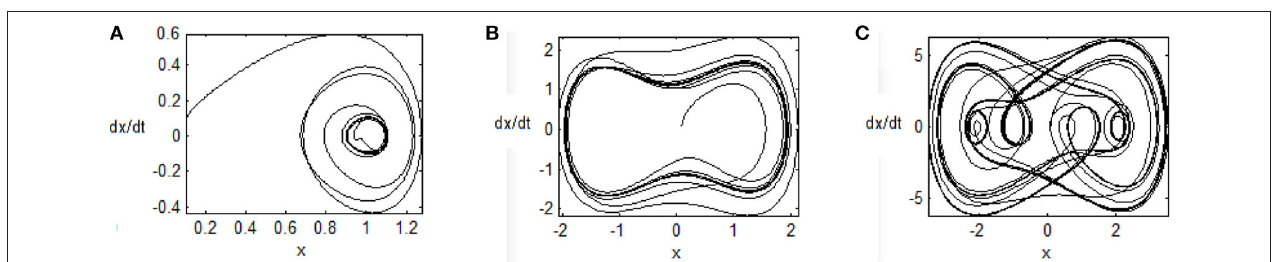
FIGURE 2 | Phase plane of uncontrolled chaotic system (A) q = 0.1, (B) q = 1, and (C) q = 8.